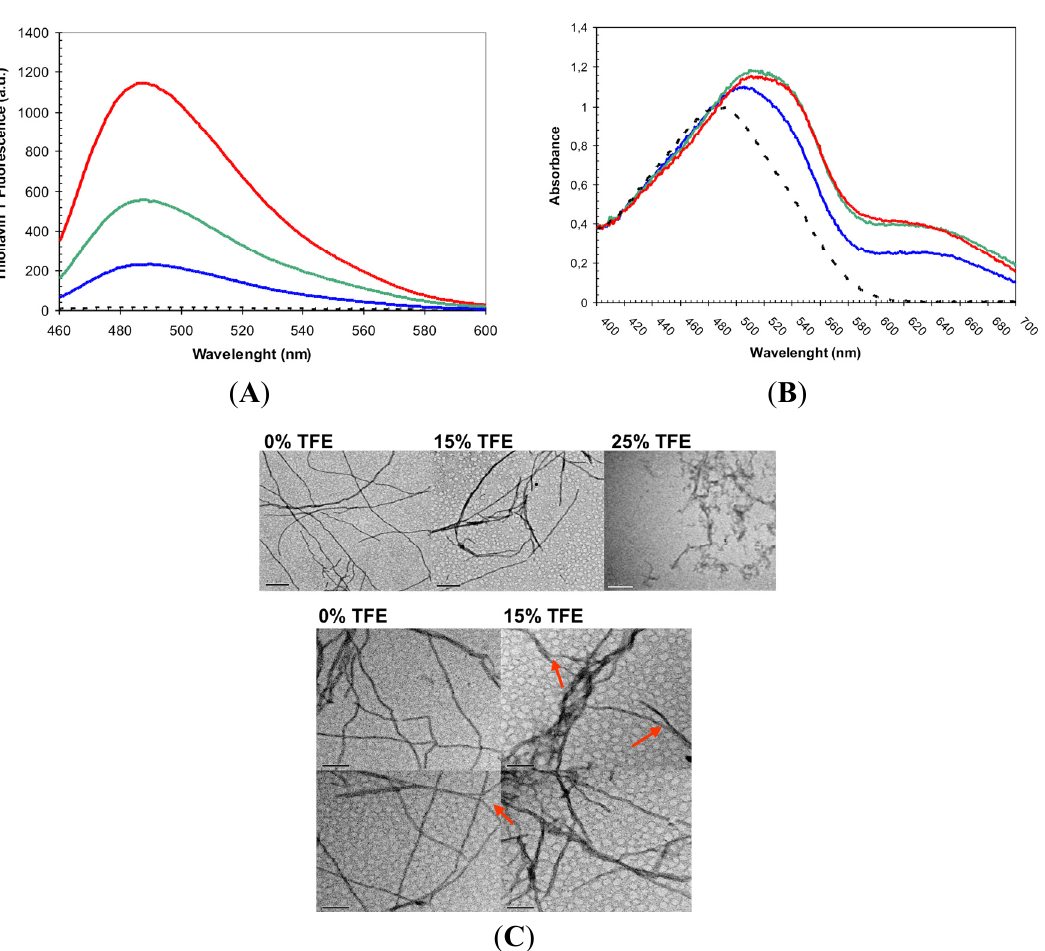
Figure 3. Amyloid-like properties of URN1-FF aggregates formed at different TFE concentrations. The protein domain was incubated at pH 2.5 and 100 μ M for one week. ( A ) Fluorescence emission spectra of ThT (25 μ M) in the absence (dotted line) and in the presence of 10 μ M of protein aggregates; ( B ) Absorption spectra of CR (20 μ M) in the absence (dotted line) and in the presence of 12 μ M of URN1-FF aggregates, in ( A ) and ( B ) protein aggregates formed at 0%, 15% and 25% TFE ( v / v ) concentrations are represented in red, green and blue, respectively; ( C ) Representative TEM images of URN1-FF solutions incubated at the indicated TFE concentrations. The bar corresponds to 200 nm and 100 nm in upper and lower panels, respectively. The arrows indicate the assembly of thin fibrils to form ticker fibrillar